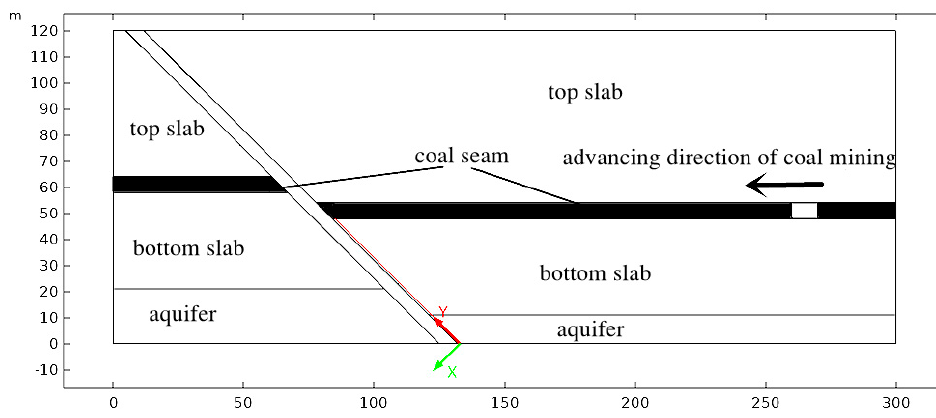
Figure 3. Numerical simulation model.